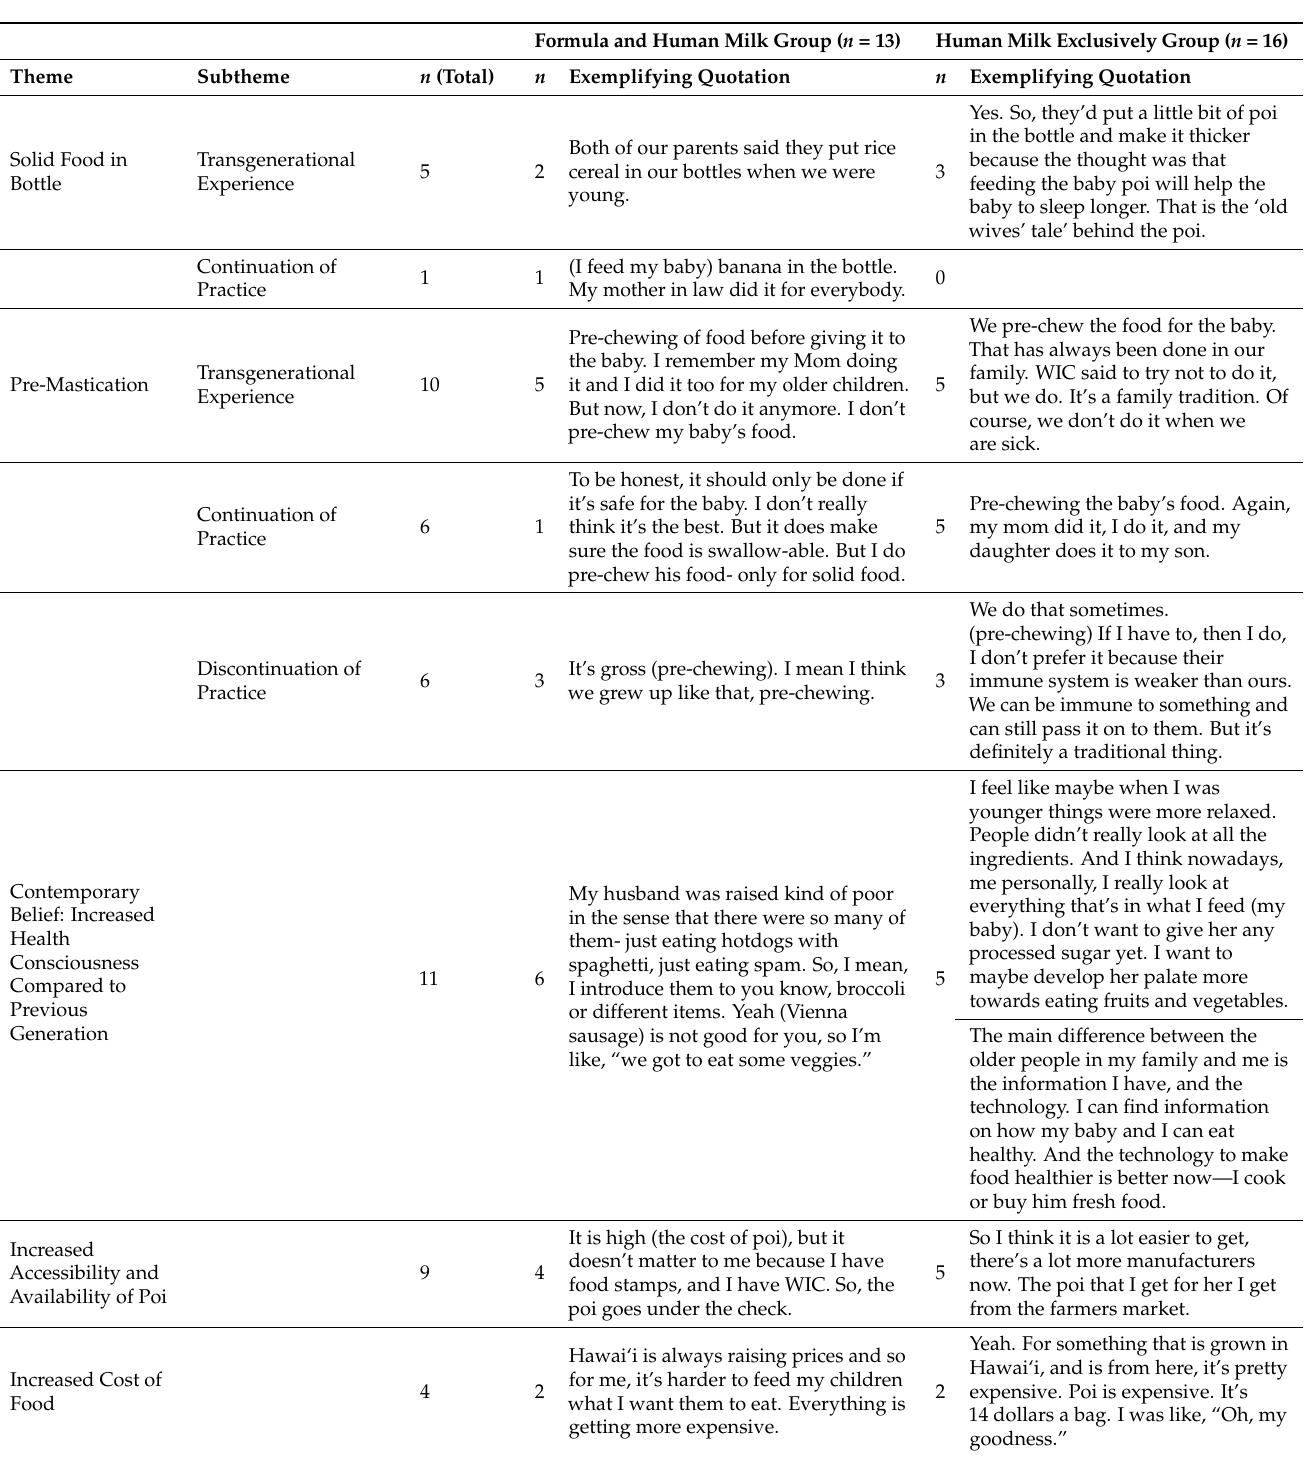
Table 6. Themes and subthemes relating Transgenerational and Contemporary Complementary Feeding Practices: Complementary Feeding Behaviors and Environment, with exemplifying quotes taken verbatim from in-depth interviews with Native Hawaiian and Other Pacific Islander, and Filipino caregivers, n =